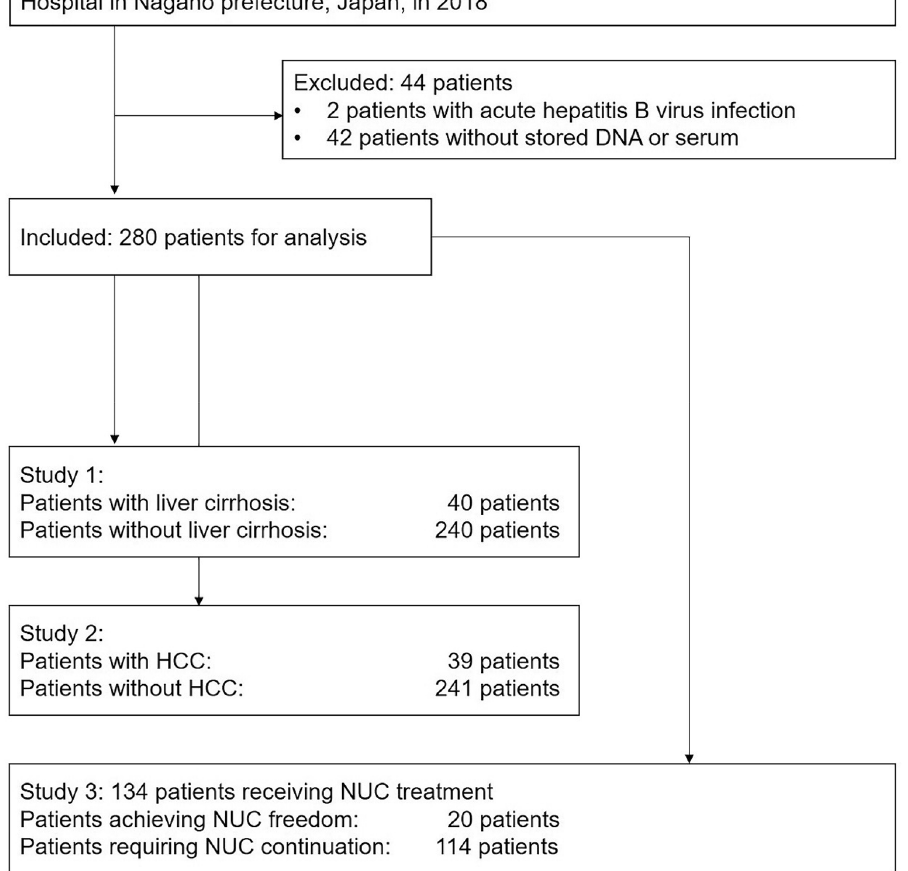
Figure 1. Study participant selection flowchart. HCC, hepatocellular carcinoma; NUC, nucleot(s)ide